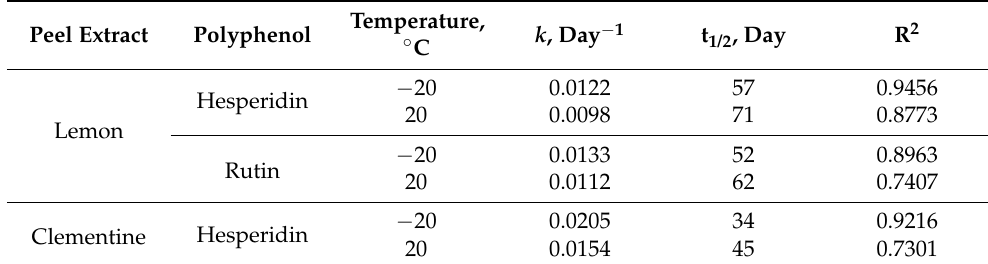
Table 4. Kinetic parameters of hesperidin and rutin degradation during storage of lemon and clementine peel extracts over 90 days.